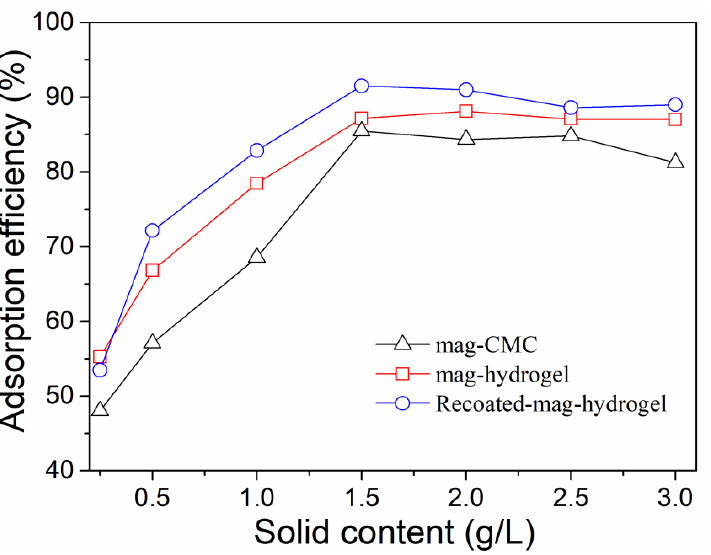
Figure 9. Effect of adsorbent content on MB adsorption onto magnetic nanocomposites.